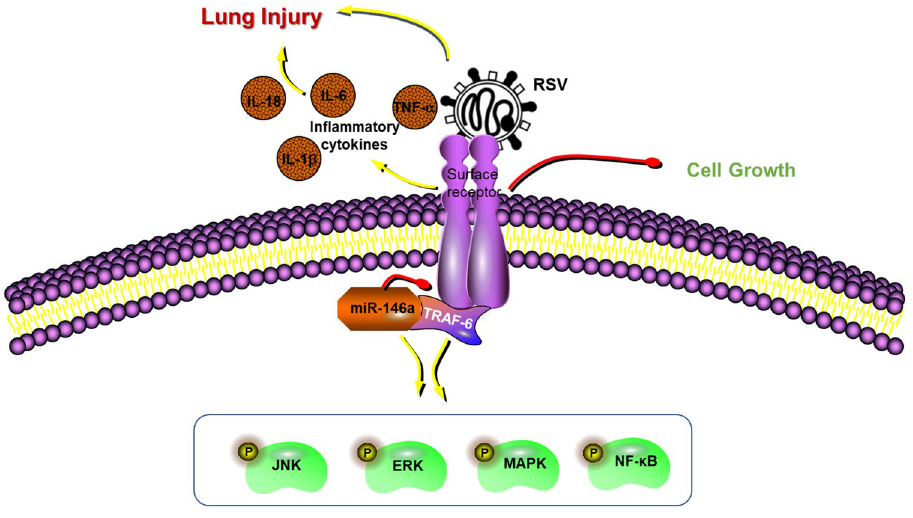
Figure 6. A Schematic diagram of the results of the